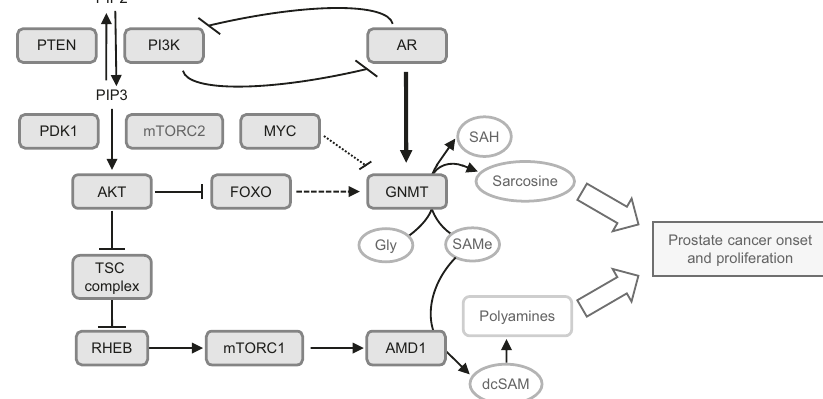
Fig. 5 Integrative view of GNMT regulation in prostate cancer. Schematic representation of Methionine cycle, Polyamine metabolism, and PI3K-mTOR axis interaction. PIP2 phosphatidylinositol 4,5-bisphosphate, PIP3 phosphatidylinositol 3,4,5-trisphosphate, PDK1 Phosphoinositide-dependent kinase 1, TSC tuberous sclerosis protein complex, RHEB Ras homolog enriched in brain, Gly genetic nature of the tumors, driven by prostate-speci fi c activation of iBET. On the other hand, we documented the negative regulation of GNMT mRNA levels by the PI3K pathway. PI3K activation, prominently the PI3K pathway. Our analysis in the mouse model, complemented with pharmacological analyses and associative studies in PCa due to alterations in PTEN , is a relevant oncogenic signal in cancer, and speci fi cally in prostate tumors [1, 8, 14] (Fig. 5). The fact that our mouse model exhibited an unexpected reduction in Gnmt expression prompted us to study the relationship between this event and the